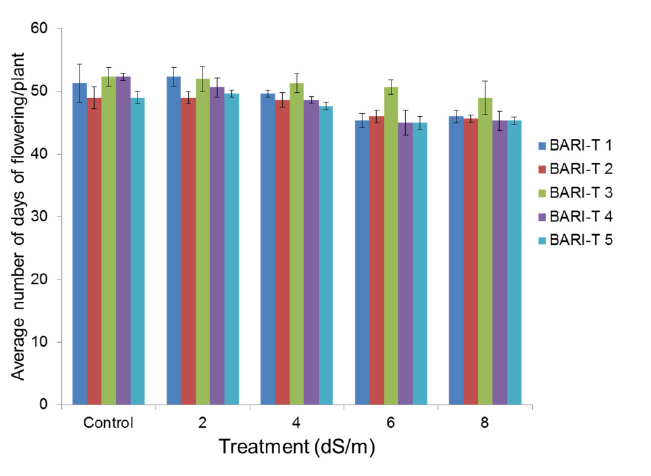
Fig. 4. Effects of NaCl-salinity on number of days of flowering in five BARI-T plants. Error bars indicate mean ± SD (n=3).